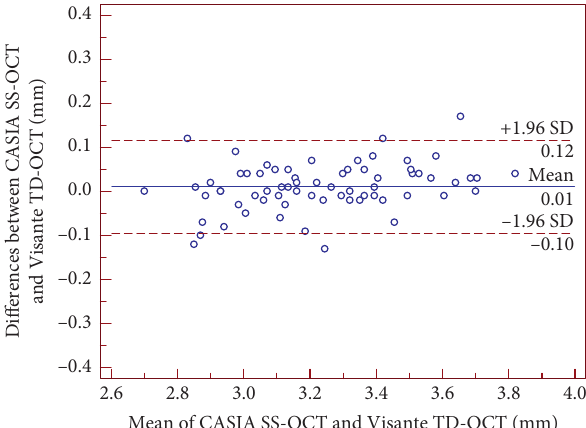
Figure 2: Bland–Altman plot showing the agreement for AQD (corneal endothelium to the anterior lens) measurements between the CASIA SS-OCT and the Visante TD-OCT. The solid line in- dicates the mean difference (bias), and the dotted lines indicate 95% limits of agreement